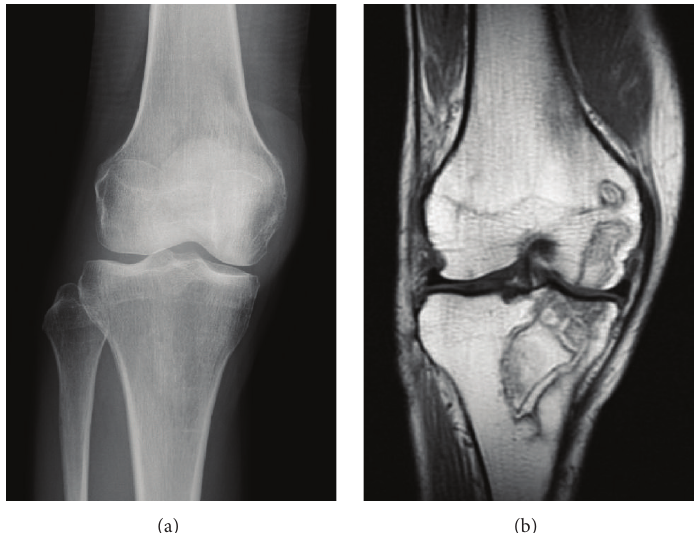
Figure 1: (a) Anteroposterior radiograph of the right knee showing increased radiodensity of the proximal half of the tibia. (b) T1W coronal section MRI showing large demarcated regions of abnormal signal intensity in the proximal half of the tibia and medial femoral condyle, with features suggestive of osteonecrosis.